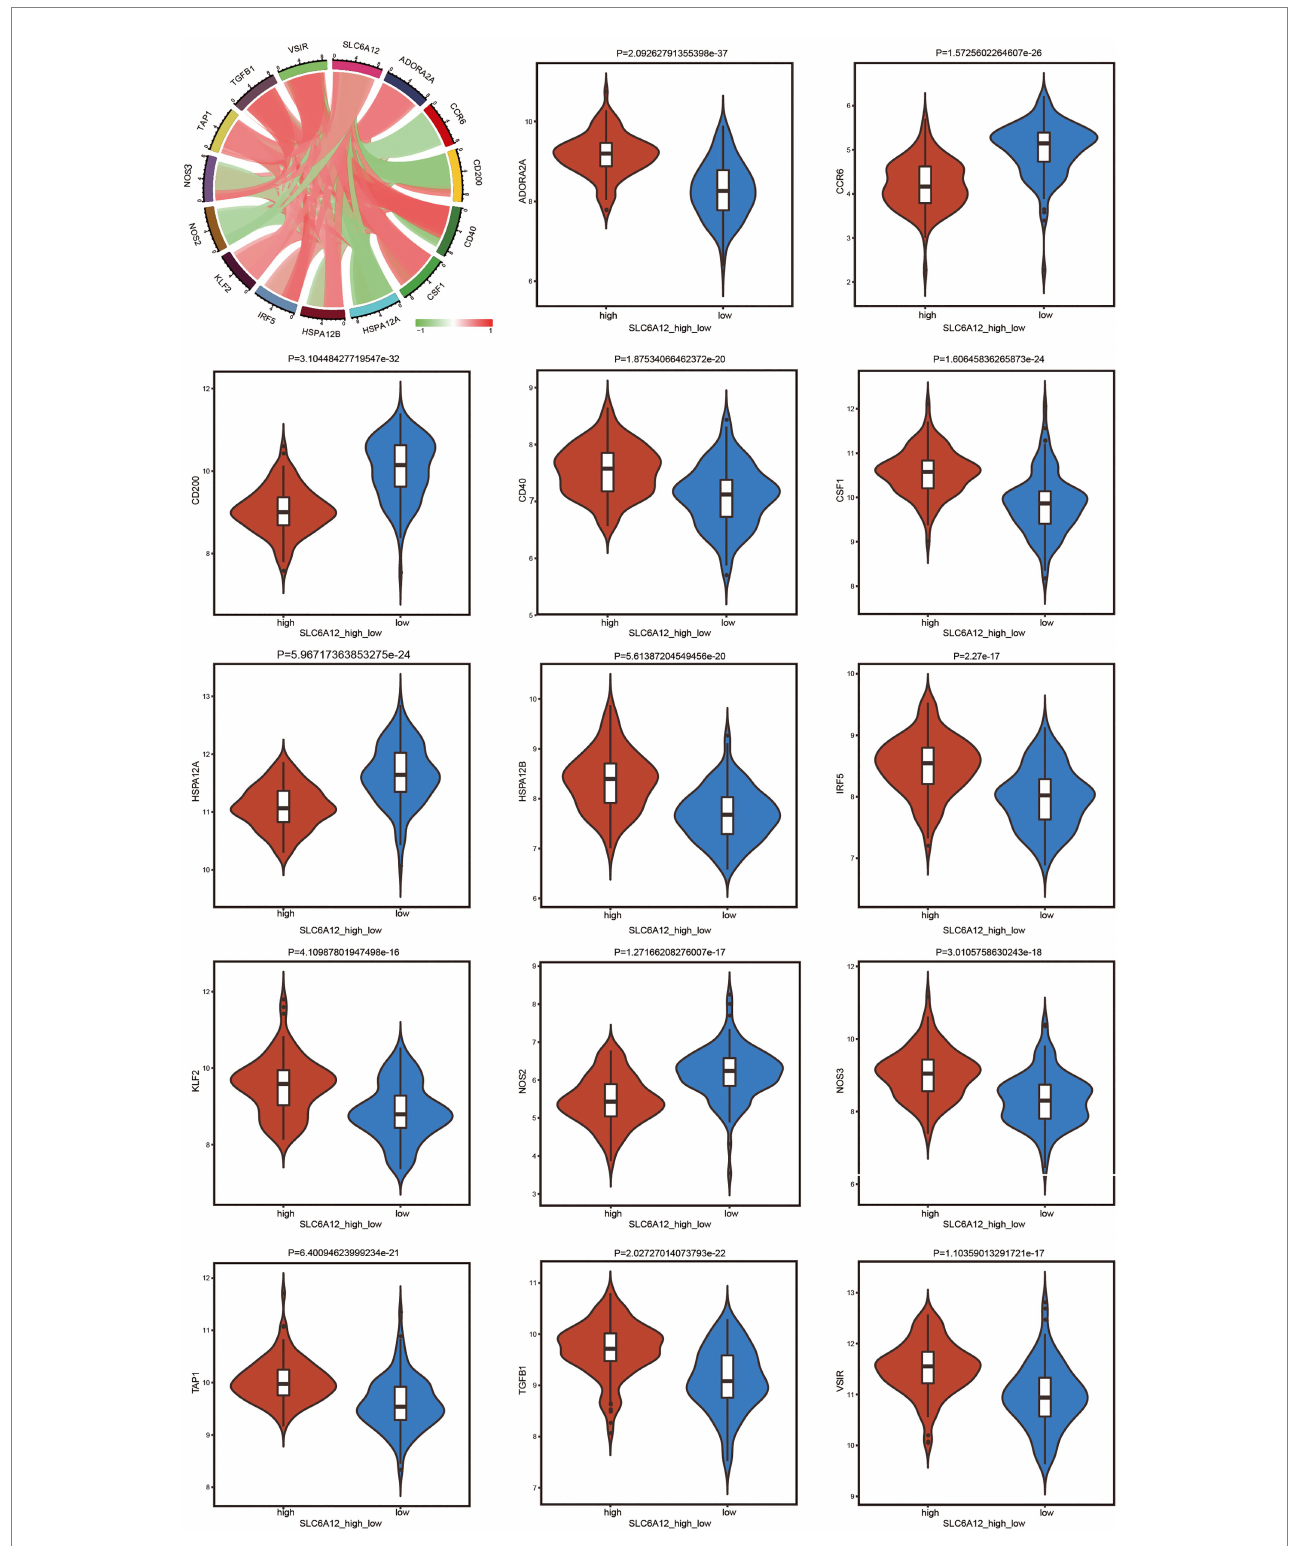
FIGURE 6 Exploring the positive and negative regulation between high or low expression of the hub gene and immune-related genes by violin plot. The thick black bar in the middle indicates the interquartile range, the black line extending indicates the 95% confidence